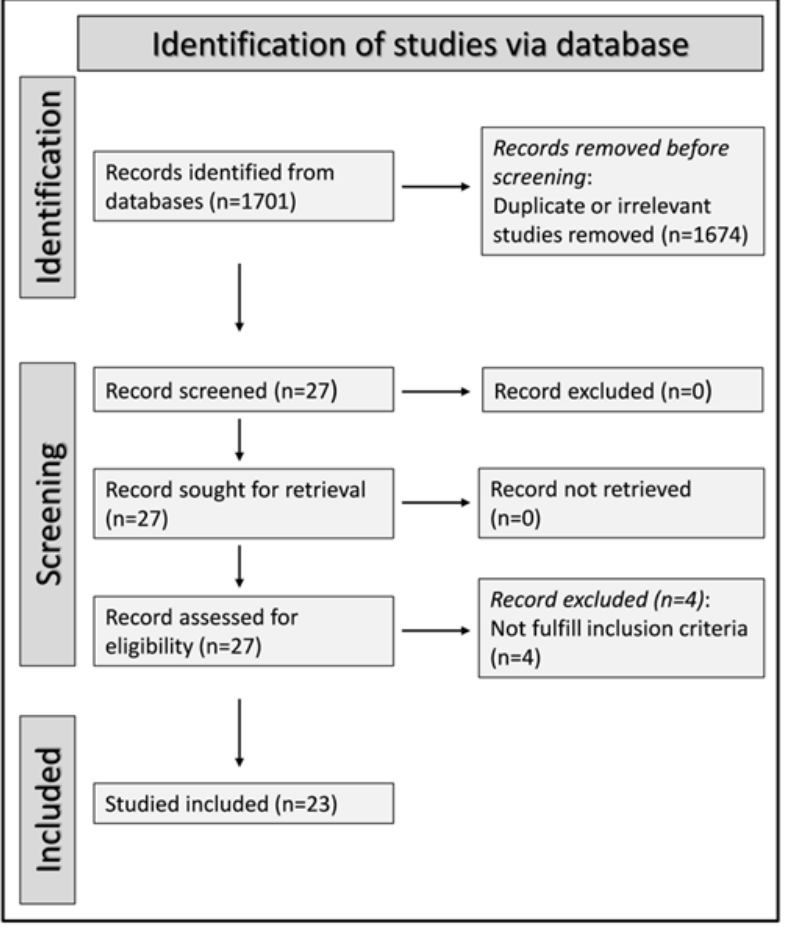
Figure 1. PRISMA 2020 flow diagram.